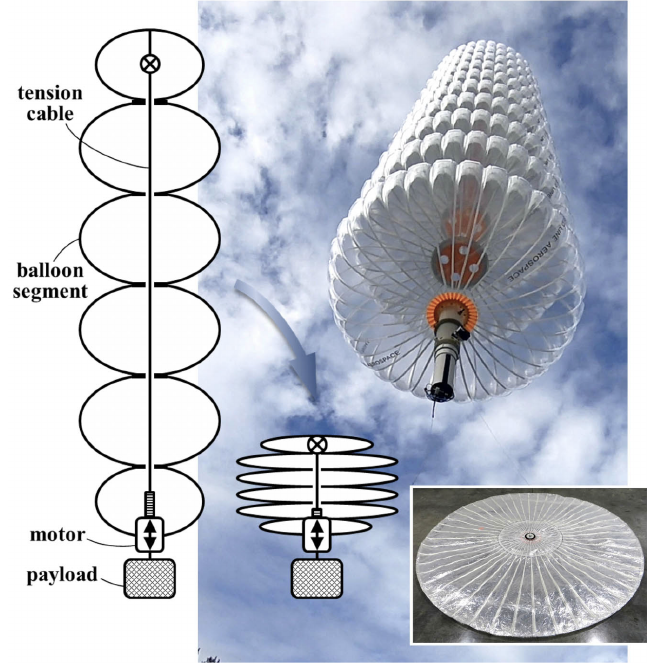
Figure 4. An illustration of mechanical compression of the VAB envelope. Pressure restraint tendons are visible in the top-right. Planar packaging configuration is visible in the